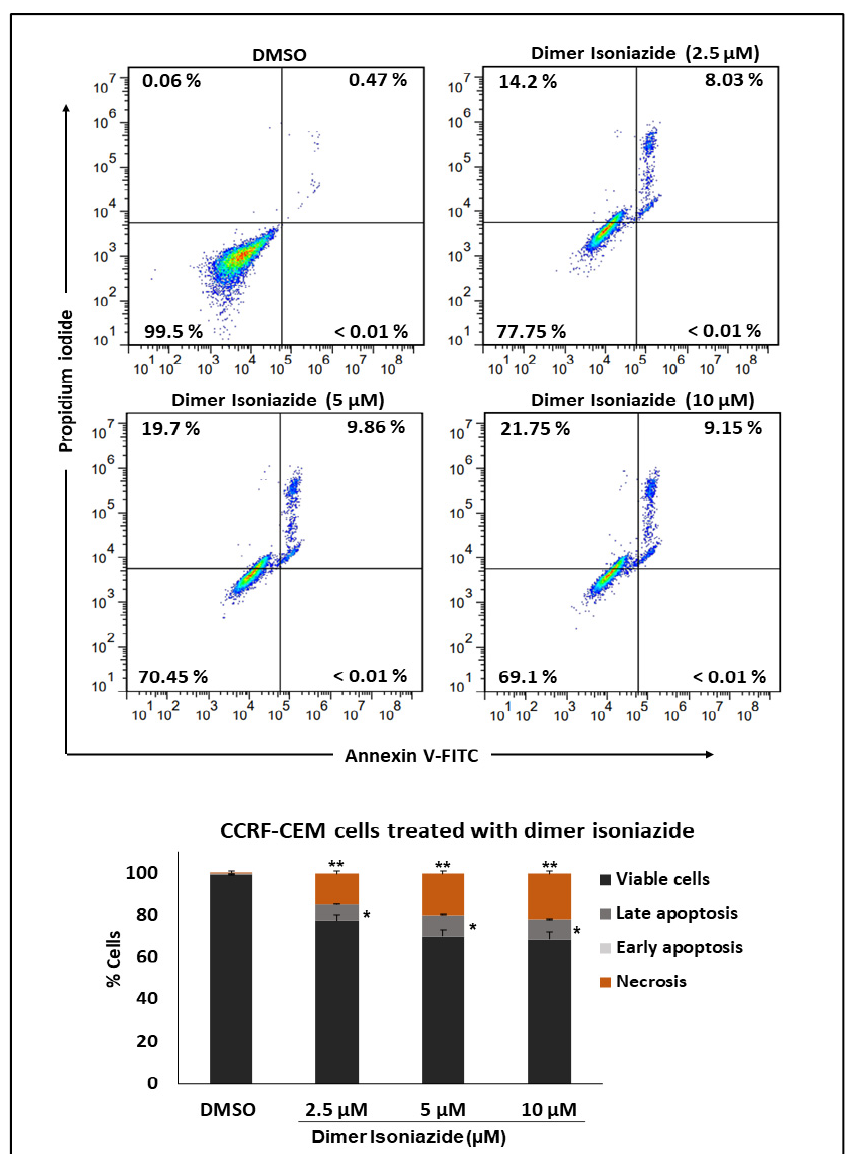
Figure 7. Detection of apoptosis by flow cytometry. Treatment with increasing concentrations of artemisinin dimer isoniazide significantly increased the percentage of necrotic as well as late apoptotic cells, while no early apoptosis was detected. Statistical significance in comparison to control (DMSO) is designated at a level of * p ≤ 0.05 and ** p ≤ 0.01.